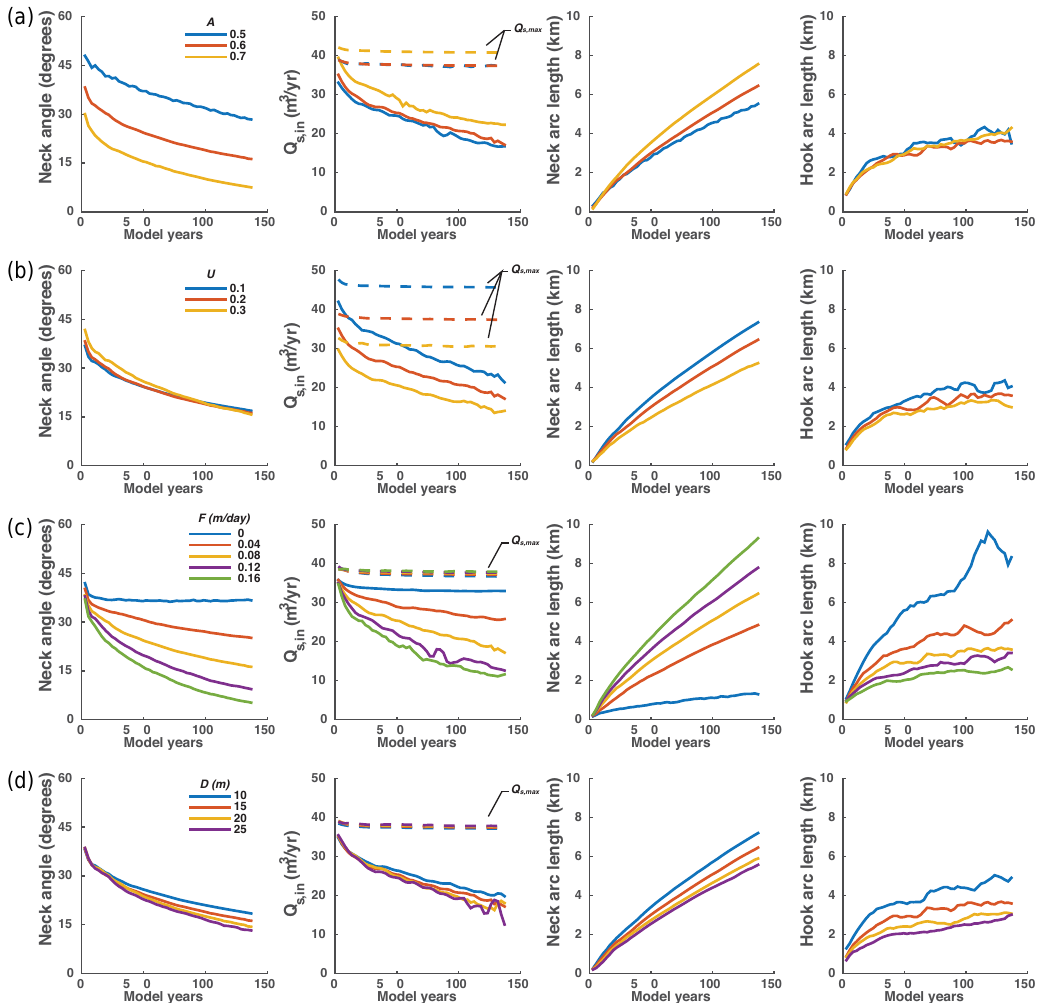
Figure 14. Spit characteristics over time for simulations with imposed rate of updrift retreat (shown in Figs. 10–13), reflecting the effect of changes in (a) wave asymmetry, (b) wave spread, (c) rate of forced retreat, and (d) shoreface/basin depth. Default run parameters are A = 0 . 6, U = 0 . 2, F = 0 . 08mday − 1 , and D =